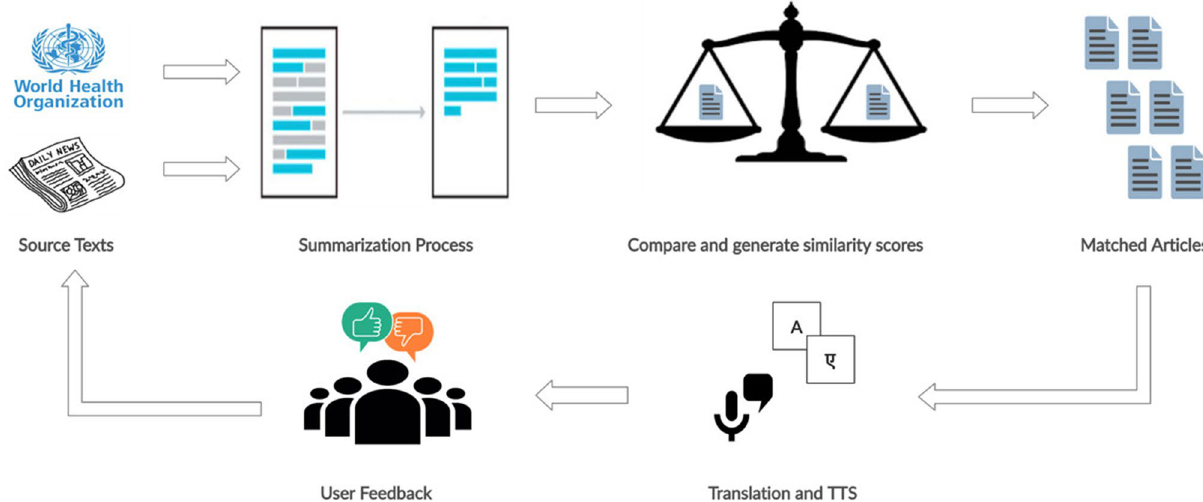
Figure 2. NLP Pipeline. The pipeline takes in news articles and the World Health Organization (WHO) reports and constructs two-level sentence similarity between titles and the full-text to build a similarity score. Finally, the relevant texts are subject to translation and text to speech conversion for local language consumption (Hindi). This figure was made using Creately (URL:https:// creat ely.